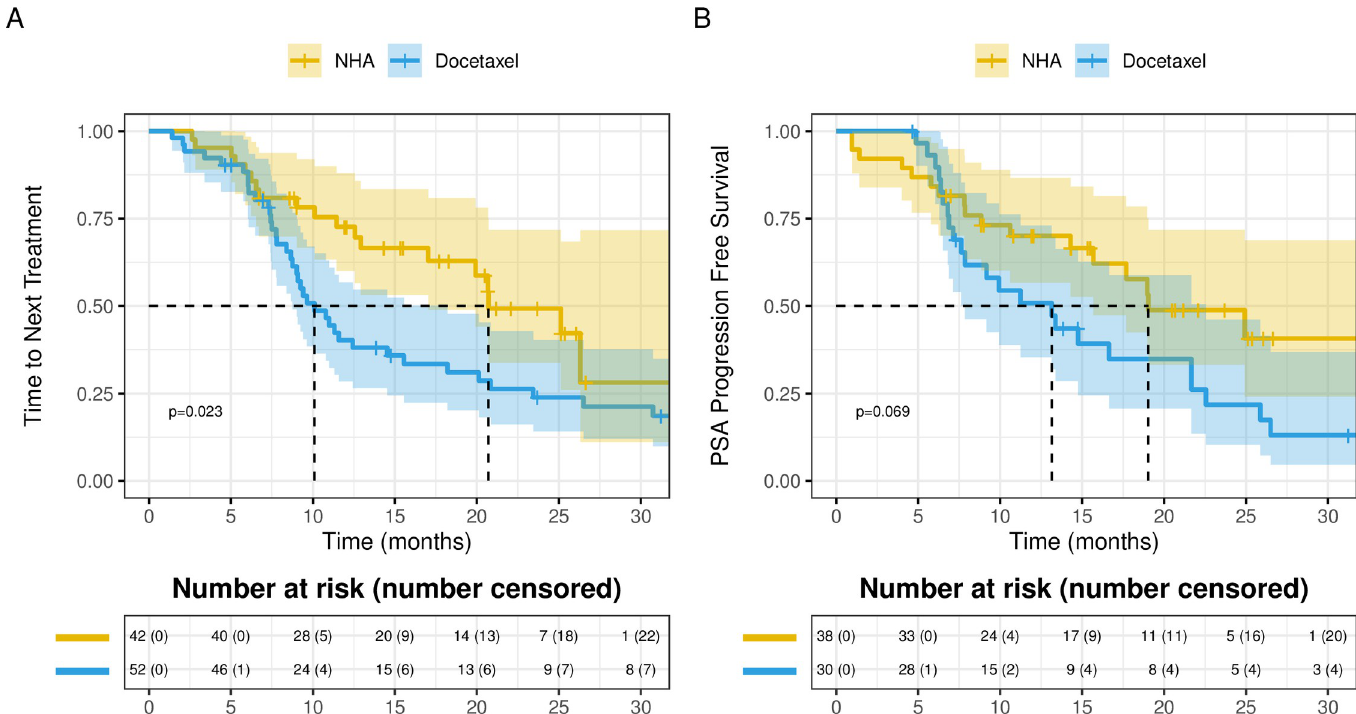
Fig 1. Kaplan-Meier analysis comparing mHSPC patients treated with upfront docetaxel versus novel hormonal therapy (NHA) using A. Failure-free survival and B. PSA Progression free survival.